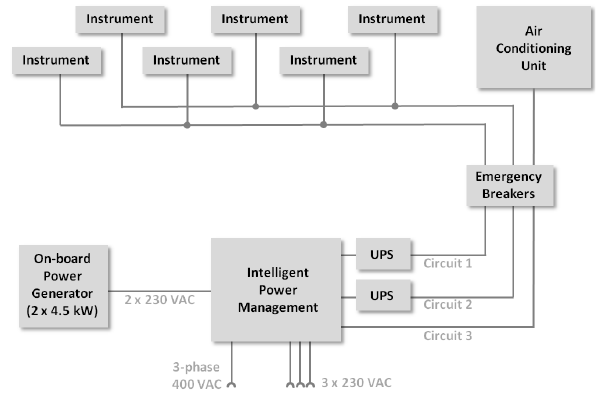
Fig. 1. Schematics of the electrical circuitry in the mobile labora- tory. Intelligent power management selects the preferred power sup- ply (on-board generated power, three individual 230 VAC lines or 3-phase 400 VAC) to feed the three power circuits on board. The two instrument circuits are buffered by uninterruptable power sup- plies